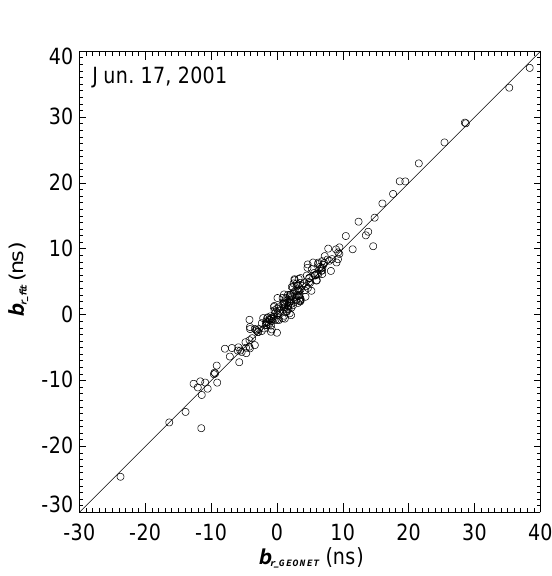
Fig. 12. Distribution of the number with the difference between GEONET derived bias and fitted bias for all receivers on 17 June